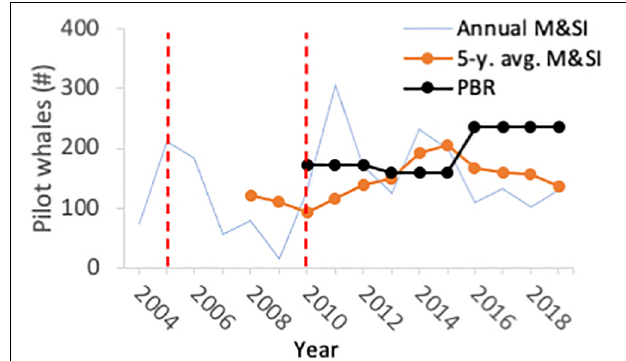
FIGURE 2 | Annual estimated mortality and serious injury (M&SI), 5 year moving average of M&SI, and potential biological removal (PBR) for short-finned pilot whales taken in the U.S. large pelagics longline fishery off the U.S. East Coast. The dashed red lines indicate the year of Pelagic Longline Take Reduction Team establishment (left, 2005) and year of publication of the final regulatory rule implementing the Pelagic Longline Take Reduction Plan (right,